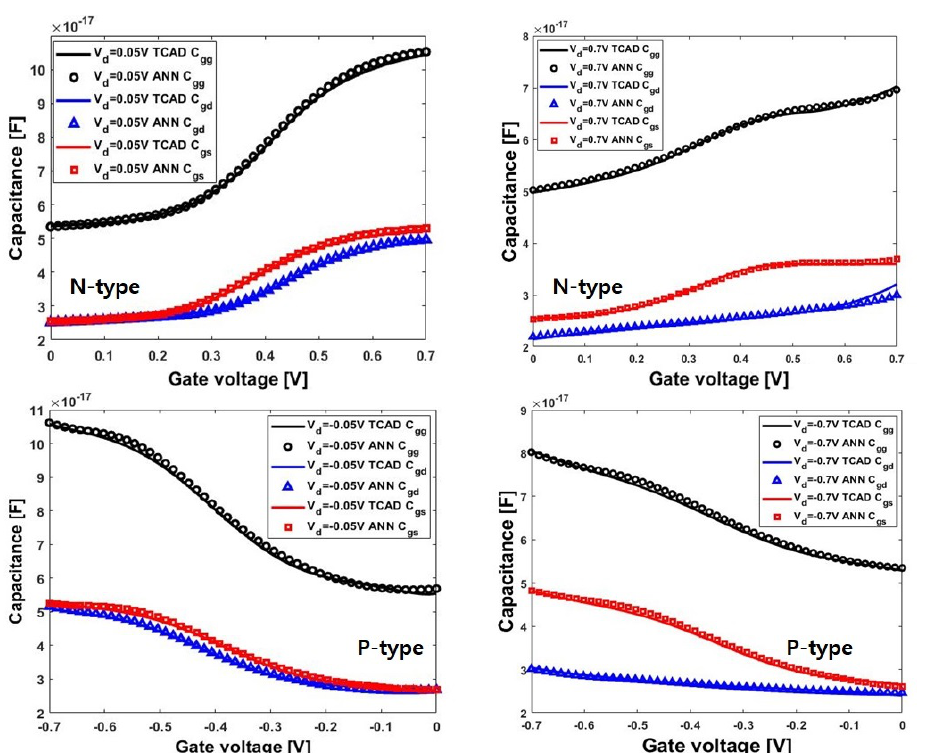
Figure 8. Comparison of the ANN model and simulated C-V characteristics using TCAD for N-type and P-type NSFETs (gate length = 12 nm, sheet width = 25 nm, sheet thickness = 5 nm, spacer length = 4 nm, oxide thickness = 1.5